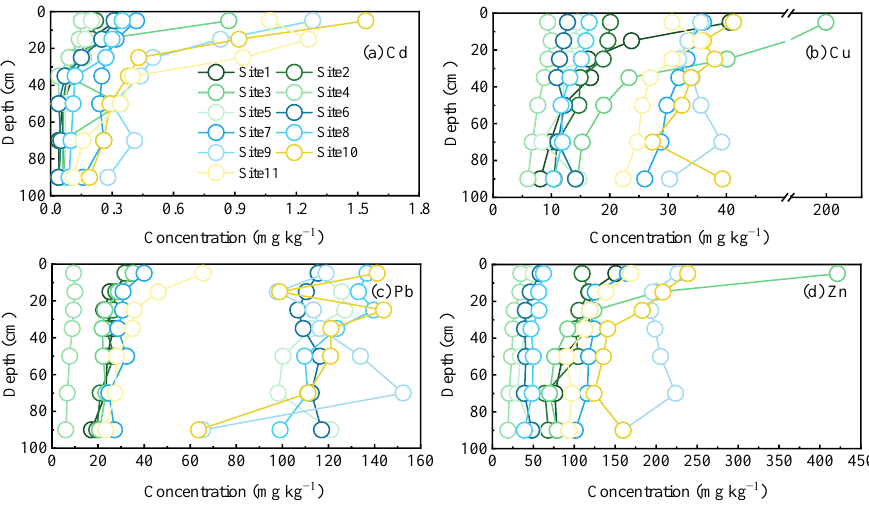
Figure 2. Concentrations of Cd ( a ), Cu ( b ), Pb ( c ), and Zn ( d ) in the soil profiles of different sam- pling sites.